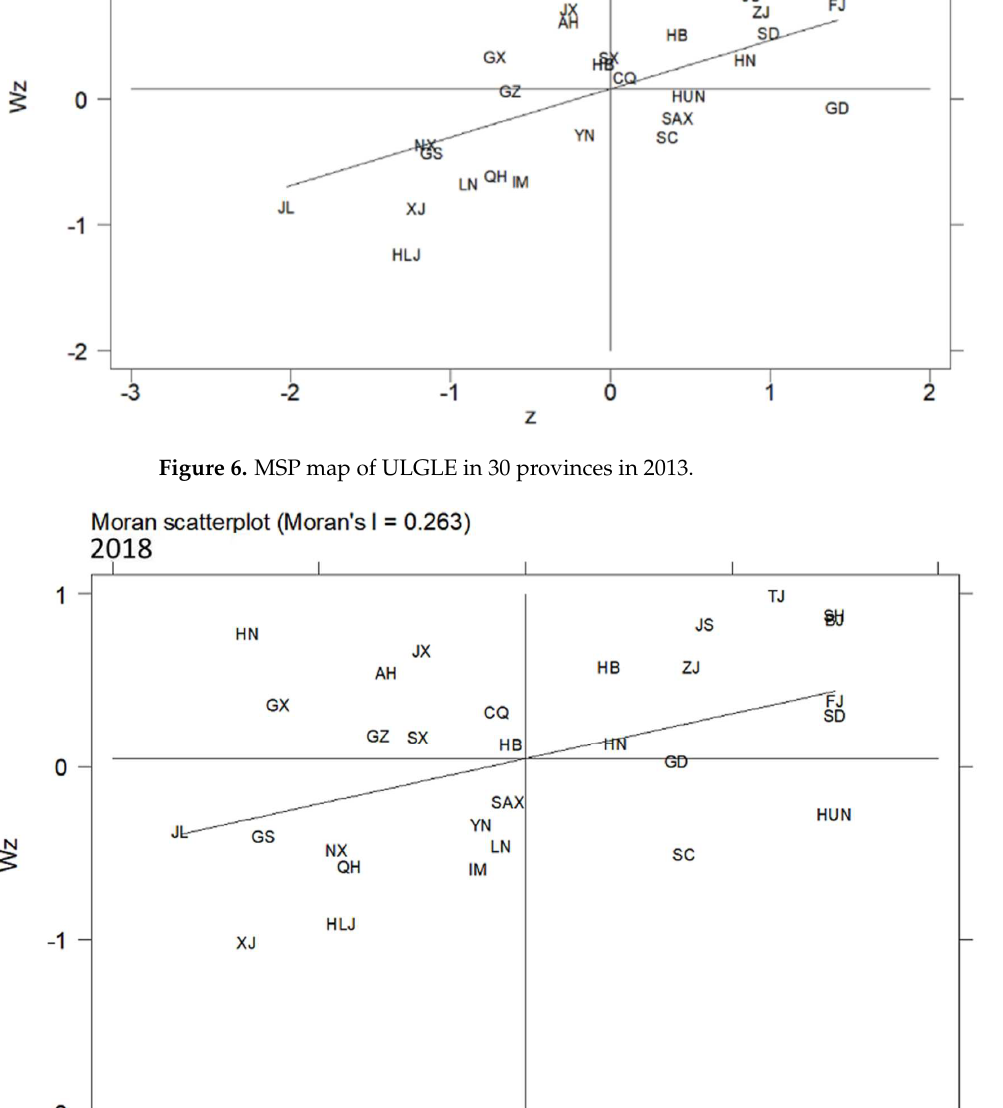
Figure 7. MSP map of ULGLE in 30 provinces in